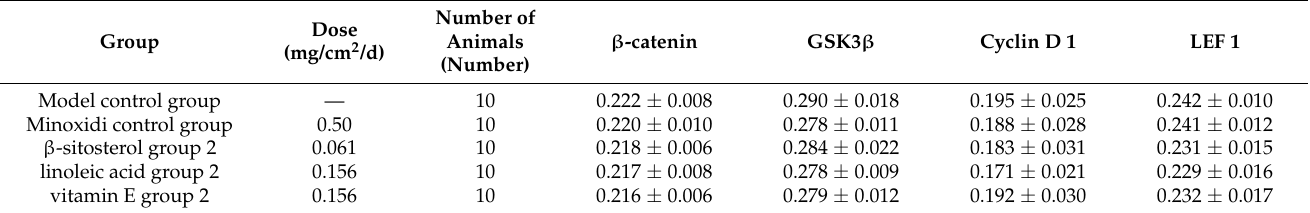
Table 18. Effects of three effective components of the kernel of P. mira on the protein expression of four targets in the Wnt/ β -catenin signaling pathway in the skin tissue of C57BL/6 mice (x ± s ).